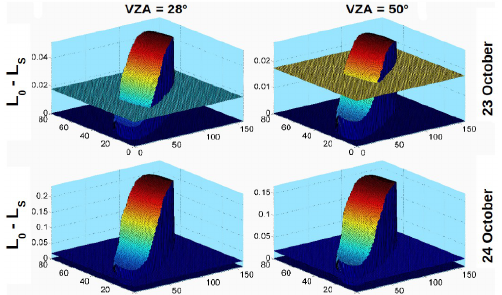
Figure 5 : 3D plots of L 0 -L s (c s ) at 7.3 m m for different at- mospheric profiles and VZA. The horizontal flat surface is the 7.3 m m NESR. In ordinate and abscissa the pixel